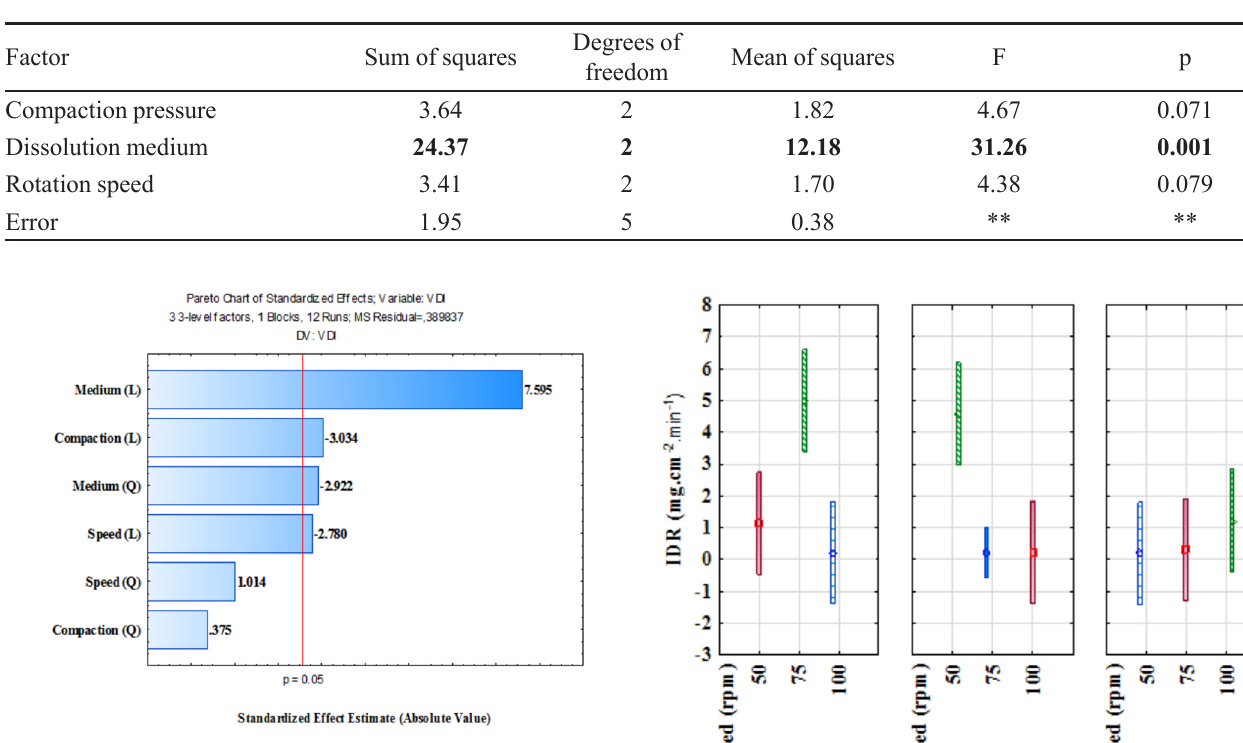
FIGURE 3 - Pareto chart representing the analysis of variance for linear (L) and quadratic (Q) components of the parameters studied. Results are significant for p > 0.05.